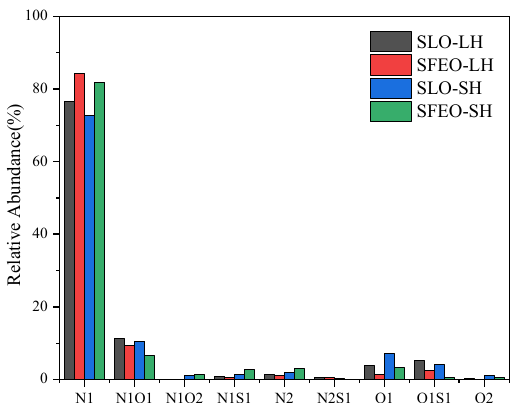
Figure 10. The relative abundance distribution of main heteroatomic compounds was detected characterized by FT-ICR MS(+ESI).